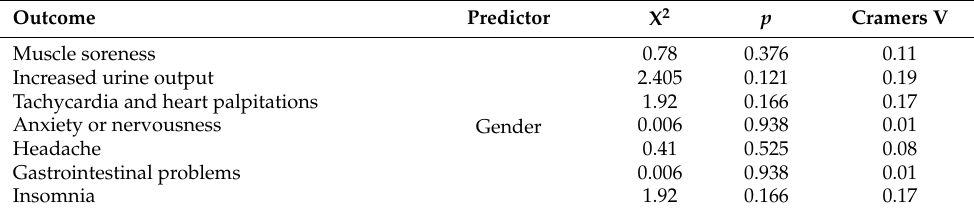
Table 4. Association between Gender predictor and certain NEGATIVE effects 24 h after CAF ingestion.